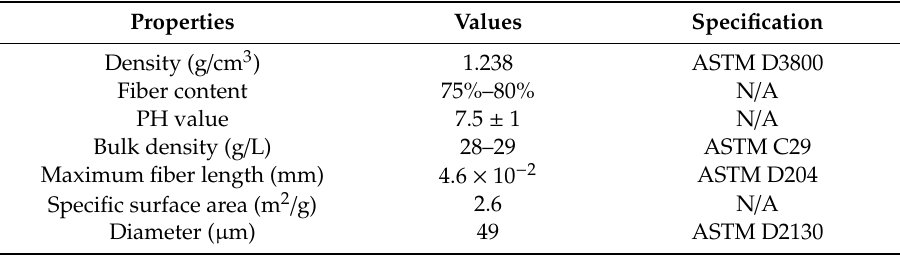
Table 4. Properties of lignin fiber (provided by